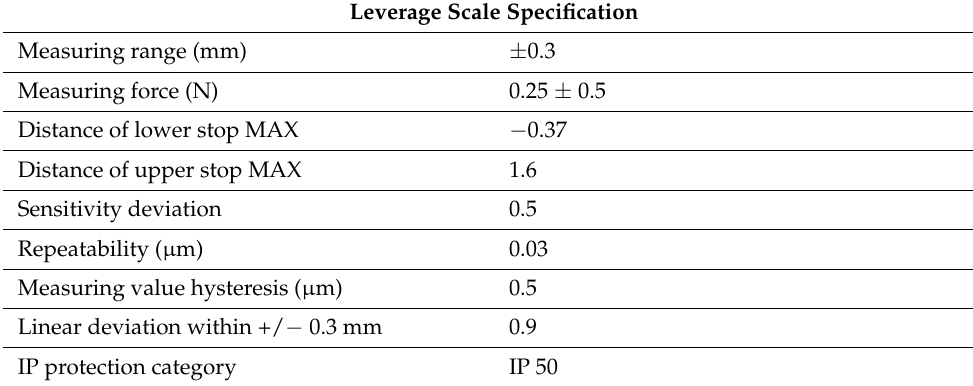
Table 4. Measuring device specification.